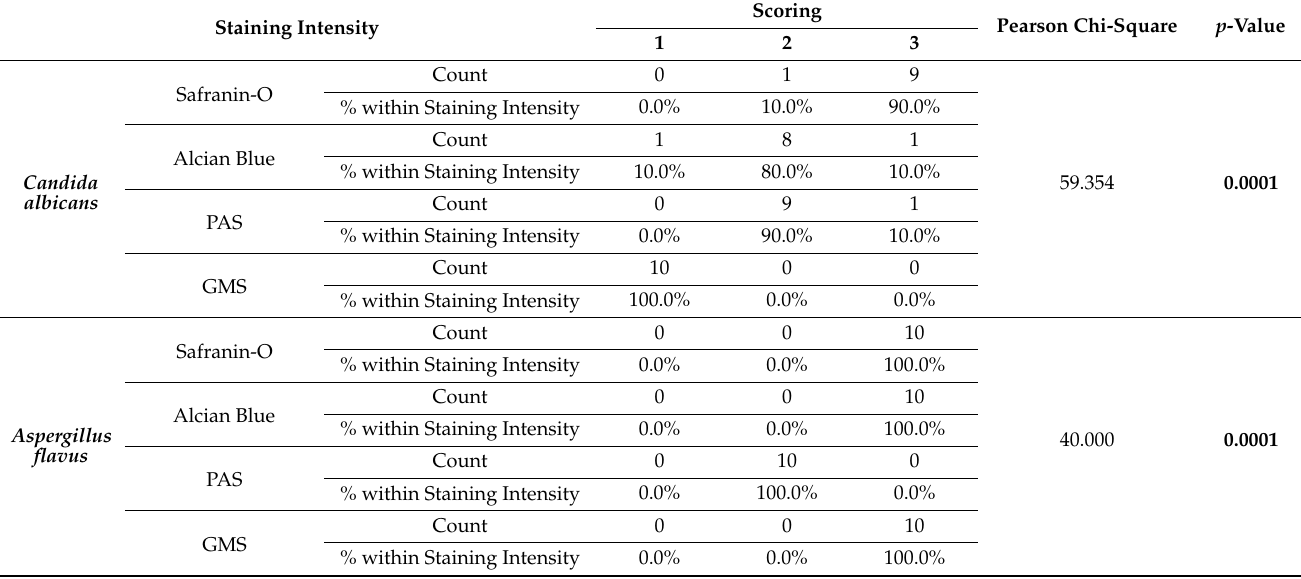
Table 3. Comparison of staining intensity of fruiting bodies (yeast/conidia/sporangia) of Candida albicans , Aspergillus flavus and Rhizopus oryzae